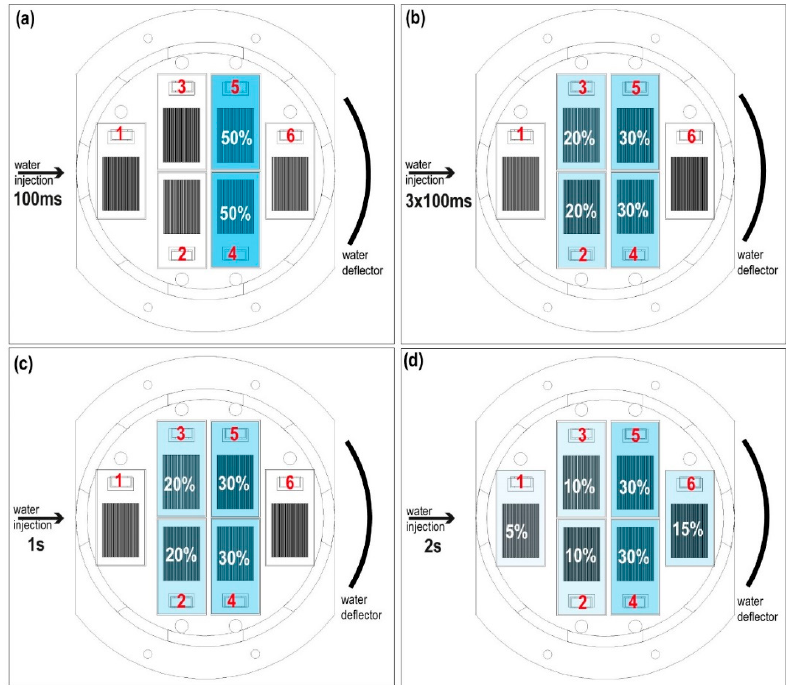
Figure 5. Top view of the “Dew sensor”. Position and coating (%) of water detectors for different injection times. The percentage and the color intensity show the total water droplets distribution. The red numbers indicate the drop water sensor position. ( a ) Pulse of 100 ms. ( b ) Combination of 2 series of 3 consecutive pulses of 100 ms with 1 s between series. ( c ) Pulse of 1 s. ( d ) Pulse of 2 s.